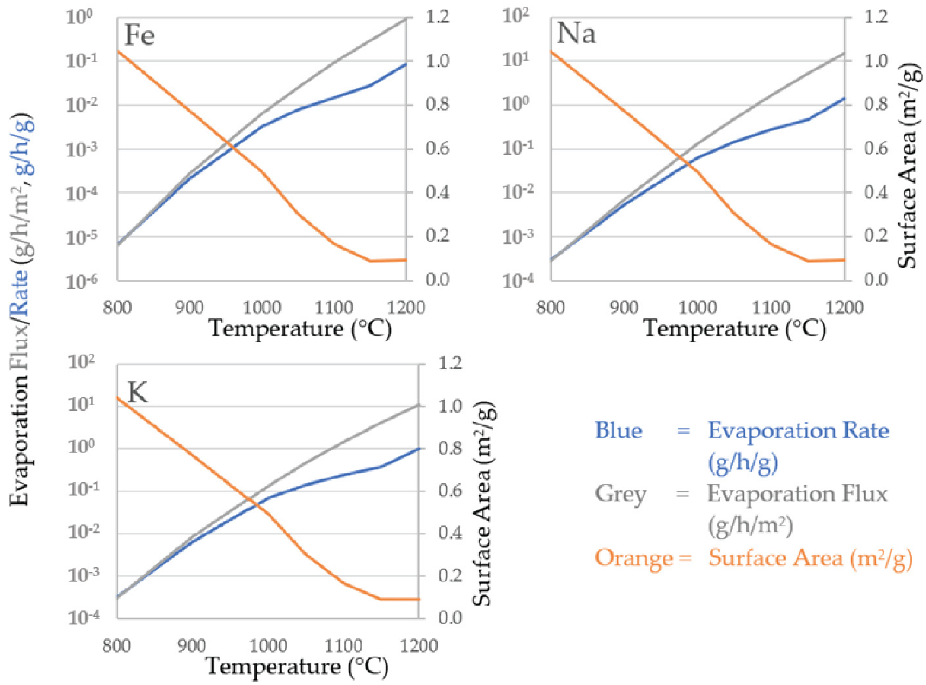
Figure 5. Predicted sublimation rate of elements Fe, Na, and K from lunar regolith, evaporation rate calculated using the HKL equation, surface area calculated from the sintering of LMS-1